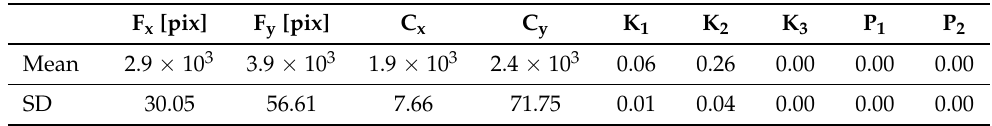
Figure 5. Reconstructed image samples from the controlled environment (Ctrl), the uncontrolled environment (Unctrl) and masked (Msk). Table 1. Camera calibration report using